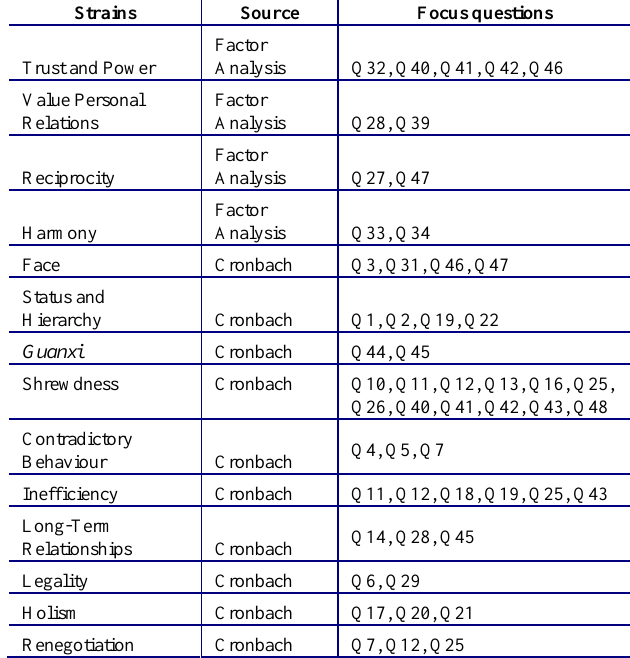
Table 4: Themes relating to hypothesis 1 Table 5: Strains listed per source